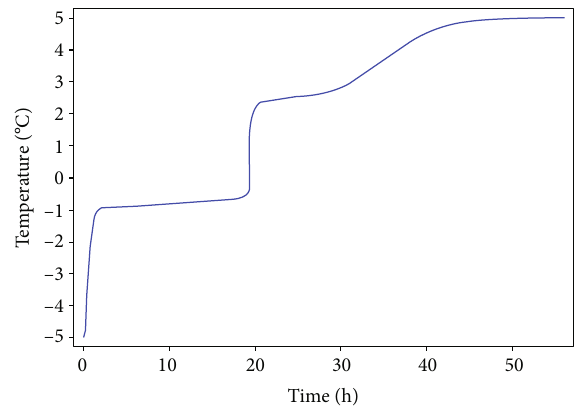
Figure 3: The minimum temperature. The minimum temperature in the channel as a function of time.